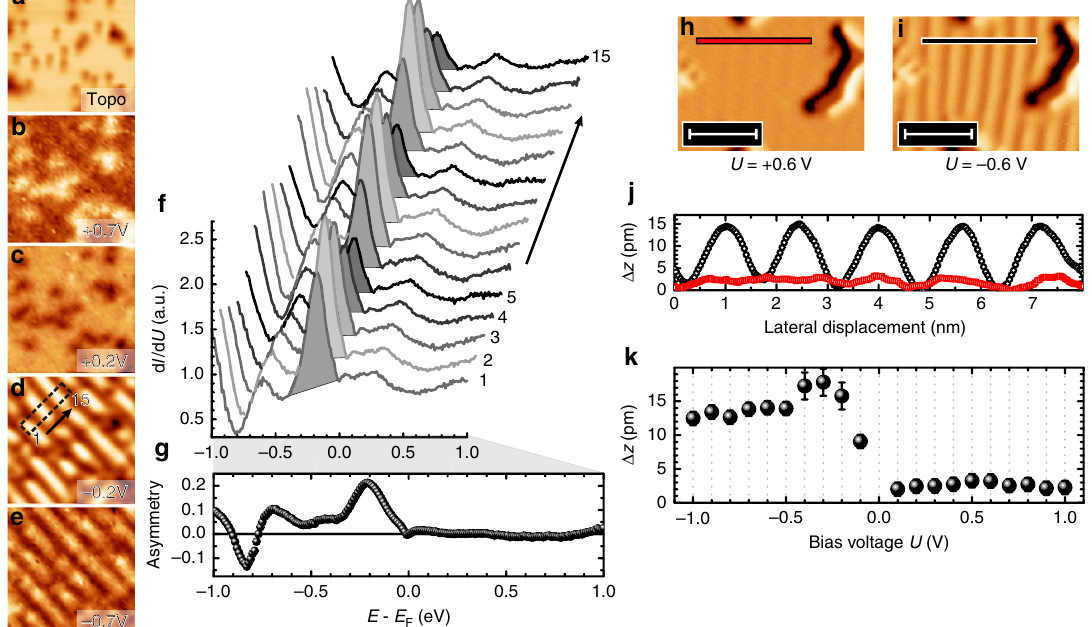
Figure 2 | STS and bias voltage-dependent corrugation. ( a ) Topography of the Fe double layer on Rh(001) and ( b – e ) d I /d U maps taken at the indicated bias voltages from constant-separation STS data (setpoint parameters: U ¼ þ 1.0V, I ¼ 500pA). The stripe pattern is only visible in the occupied energy range. Image sizes are 15 (cid:2) 15nm 2 . ( f ) Tunnelling spectra measured along the box in d . The peak at (cid:3) 0.2V is more intensive on the bright stripes than between them. ( g ) Plot of the electronic asymmetry as a function of bias voltages. Although the electronic asymmetry is negligible in the empty states, it becomes maximal in the occupied states at about (cid:3) 0.2V. ( h , i ) Topographic images taken at U ¼ þ 0.6V and (cid:3) 0.6V. Scale bars, 5nm. ( j ) Averaged line sections measured along the red and black lines. ( k ) Bias dependence of the corrugation. Error bars are given by standard deviation of corrugation peak heights measured at corresponding bias